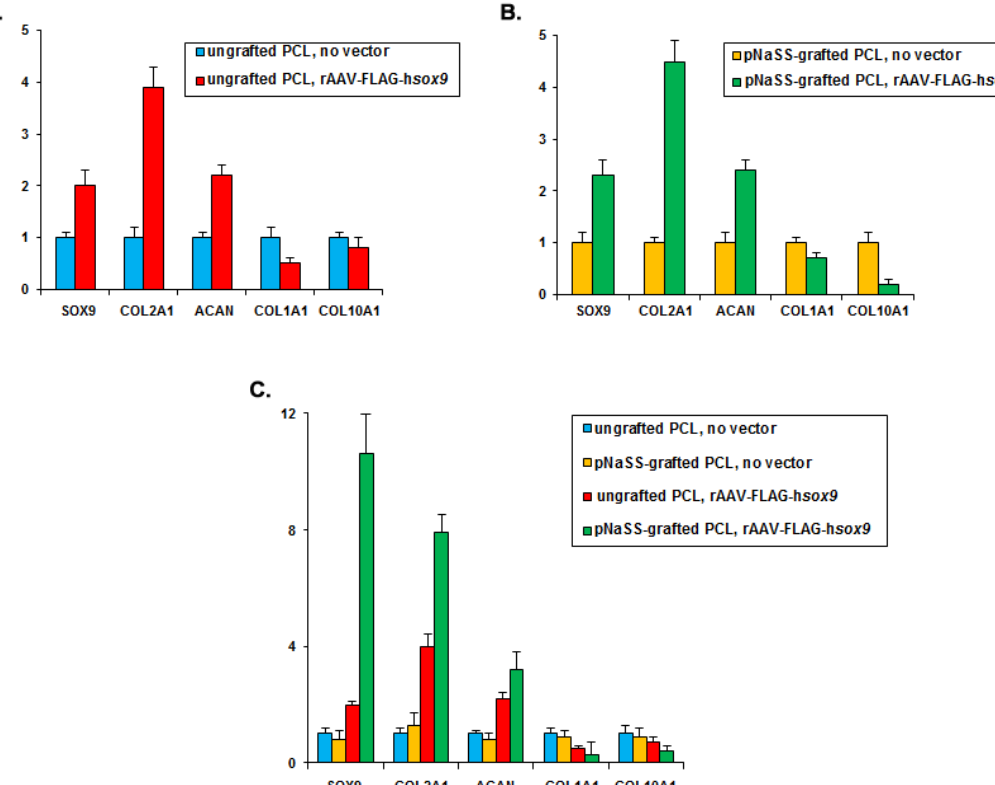
Figure 4. Induction of chondrogenic expression profiles and reduction of osteogenic and hypertrophic expression in human bone marrow aspirates transduced with rAAV sox9 -coated PCL films. pNaSS-grafted and ungrafted PCL films were coated with rAAV-FLAG-h sox9 or let without vector treatment prior to incubation with the aspirates and the profiles of SOX9, COL2A1, ACAN, COL1A1, and COL10A1 versus GAPDH were evaluated by real-time RT-PCR after 21 days (( A , B ): fold inductions relative to samples receiving each respective PCL films without rAAV; ( C ): fold inductions relative to samples receiving ungrafted PCL films without rAAV; data from all patients).